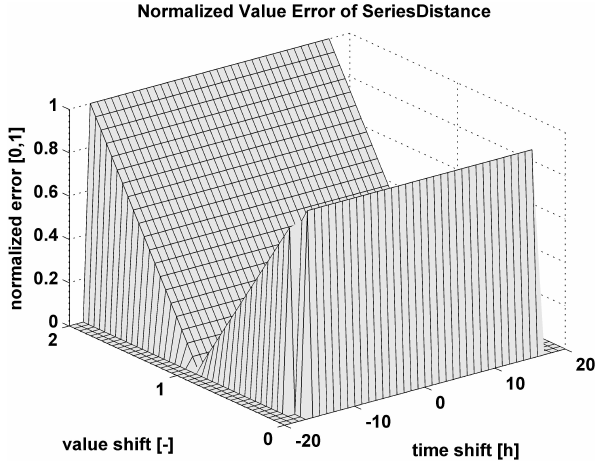
Fig. 8. Error surface of the timing error of the Series Distance (SD) for synthetic, triangular events as shown in Fig. 1. Simulations are shifted in time (offset range [ − 20h, 20h]) and amplitude (multi- plier range [0, 2]). The error surface is normalized to [0, 1] by means of division with the maximum